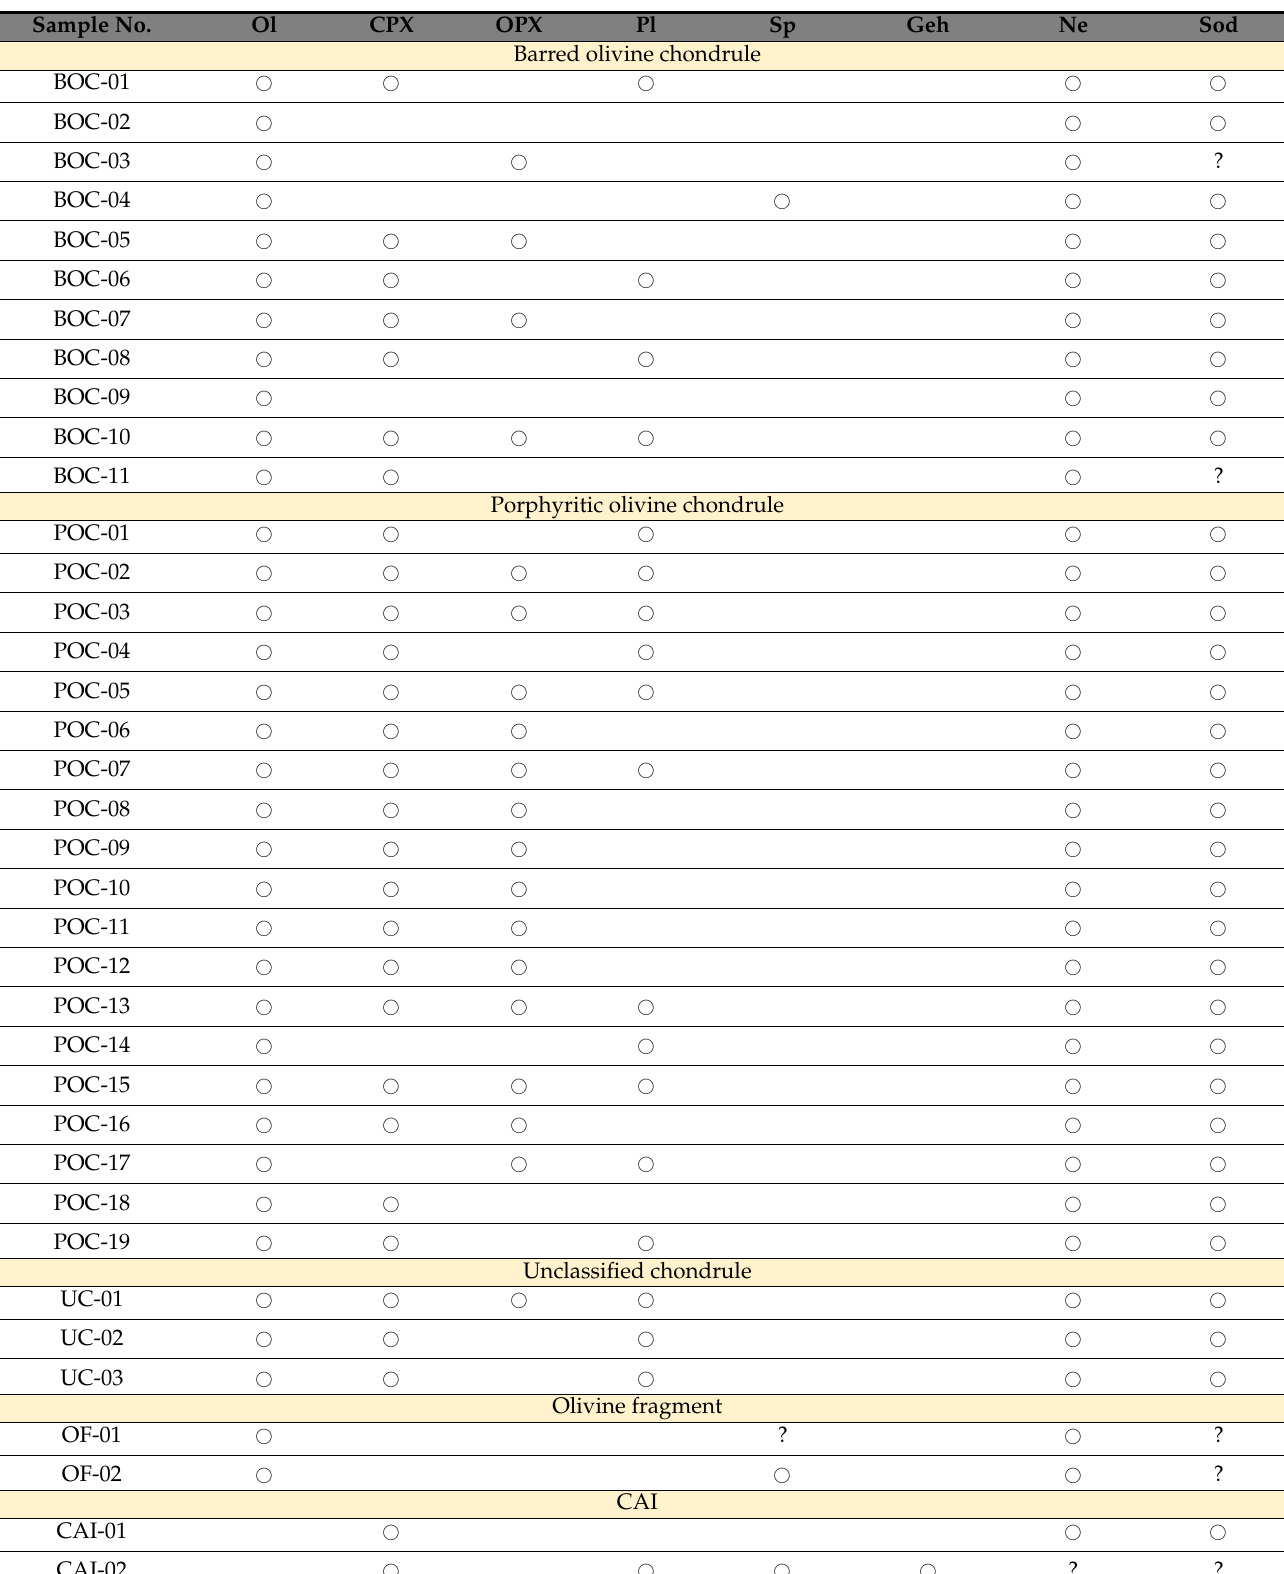
Table 1. Mineral phases observed in each object. Mineral abbreviations: olivine—Ol, low-Ca pyroxene—OPX, clinopyroxene—CPX, plagioclase—Pl, spinel—Sp, gehlenite—Geh, nepheline—Ne,